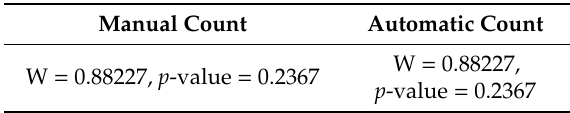
Table 4. Results of the normality test for the manual count data set (left) and the automatic count data set (right). None of the tests were statistically significant. Thus, we did not find statistical significance to state that any of the data sets were not normally distributed. Therefore, we considered that they complied with the bivariate normality assumption, and proceeded to study their correlation with Pearson’s